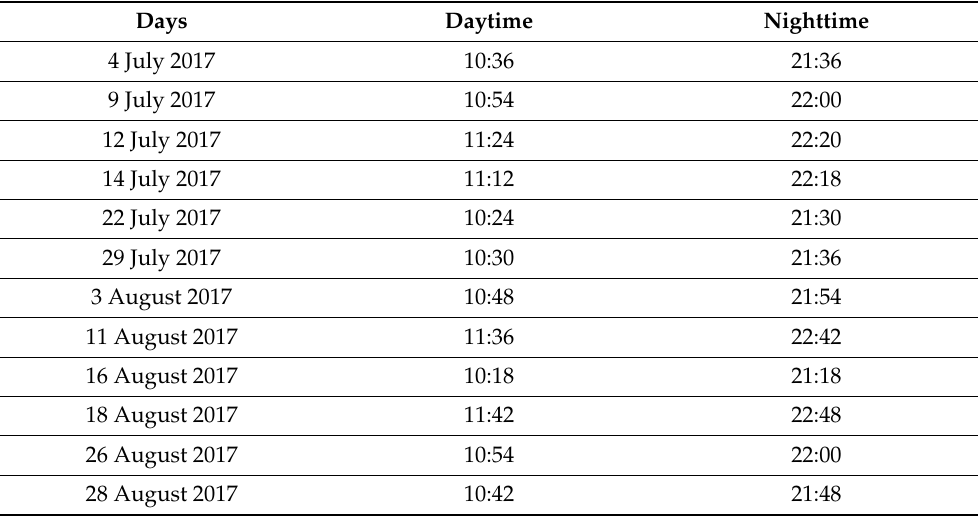
Table 1. Overpass time of the satellite for the twelve investigated days. Greenwich Mean Time